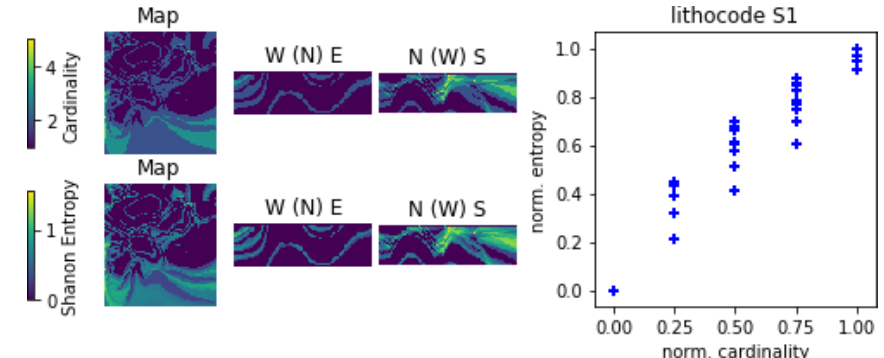
Figure 14. Comparison of local uncertainty measures for an ensemble of 10 lithocode 3D voxets for scenario 1; 3D visualisation looking from the NW of the voxet, the top surface of the voxet an EW section at the northern face of the model looking from the south, a NS section on the western face of the voxet looking from the east.